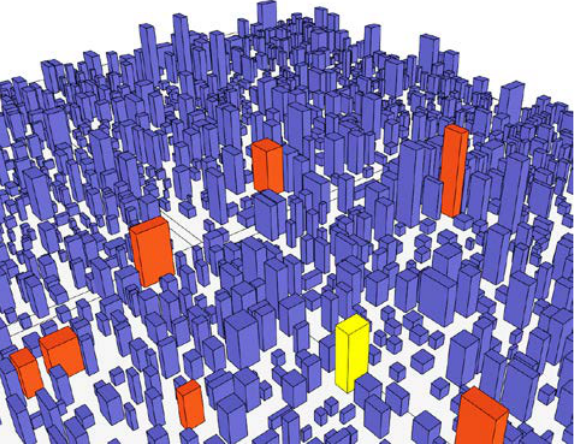
Figure 9. List of competitors from new opening